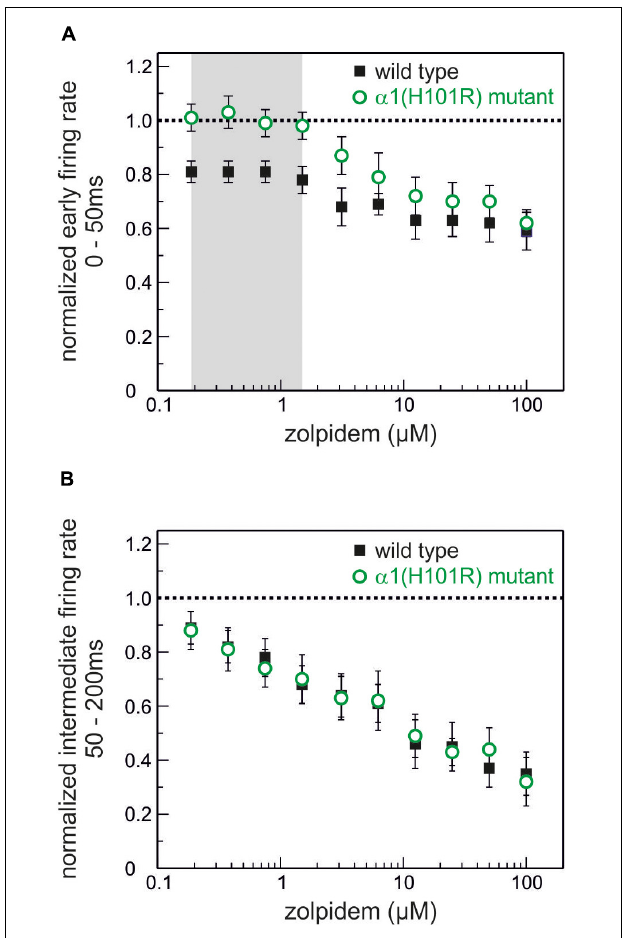
FIGURE 5 | Actions of the α 1-GABA A receptor-preferring drug zolpidem on neuronal activity. (A) Effects of zolpidem (concentration range 188 nM – 100 µ M) on the normalized action potential rate during phases of high neuronal activity (0 – 50 ms after the beginning of an up state) in wild type (black) and GABA A α 1(H101R) (green) cultured cortical neurons. The network-depressant action of zolpidem at low concentrations (up to 1.5 µ M, marked in gray) is absent in neurons from GABA A α 1(H101R) mice. Starting at a concentration of 3.125 µ M inhibition of action potential firing during phases of high neuronal activity can be observed in GABA A α 1(H101R) neurons and at higher concentrations runs parallel to the effects in wild type neurons (mean ± SEM, n = 22 – 46 for wild type and 8 – 38 for α 1(H101R) mutant). (B) Effects of zolpidem on intermediate neuronal activity (during the time window of 50 – 200 ms after the beginning of an up state). Zolpidem depresses neuronal activity in a concentration-dependent manner in both wild type (black) and GABA A α 1(H101R) (green) cortical neurons (mean ± SEM, n = 16 – 41 for wild type and 12 – 34 for α 1(H101R) mutant). Unlike in A (high neuronal activity 0 – 50 ms after up state initiation) there is no difference between the action of zolpidem in wild type and GABA A α 1(H101R) neurons. Data is displayed as mean ±